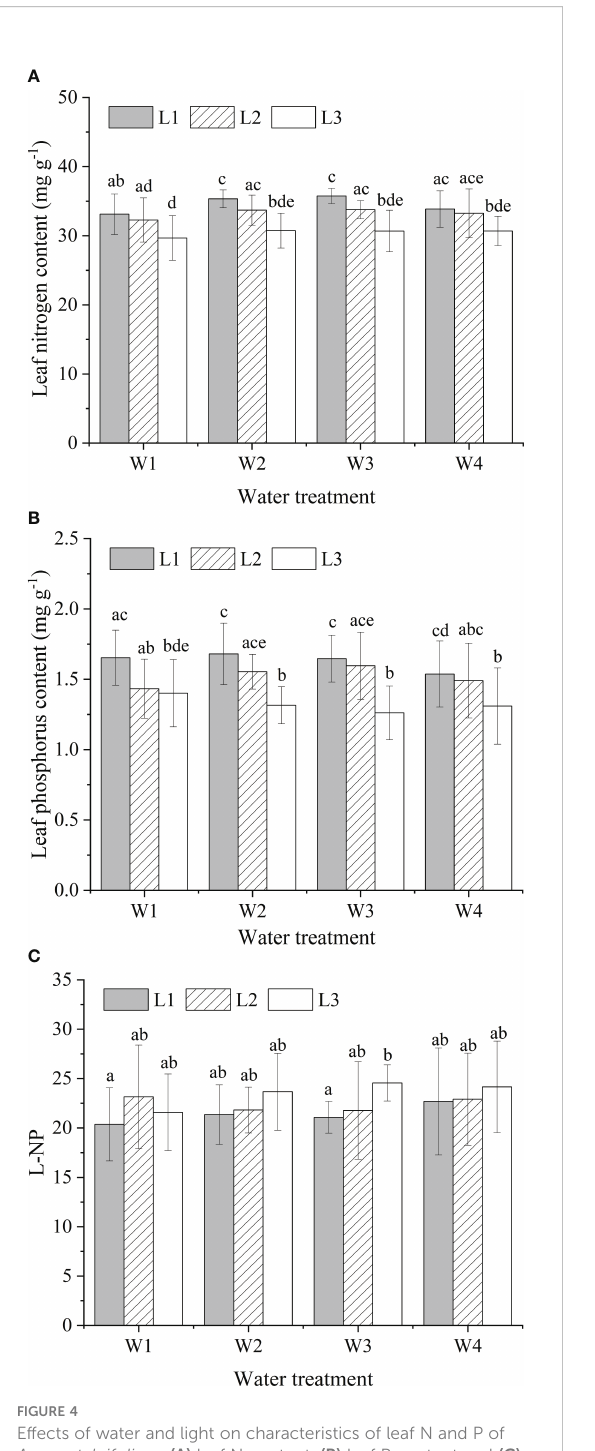
FIGURE 4 Effects of water and light on characteristics of leaf N and P of Acer catalpifolium . (A) leaf N content, (B) leaf P content and (C) leaf N/P ratio.